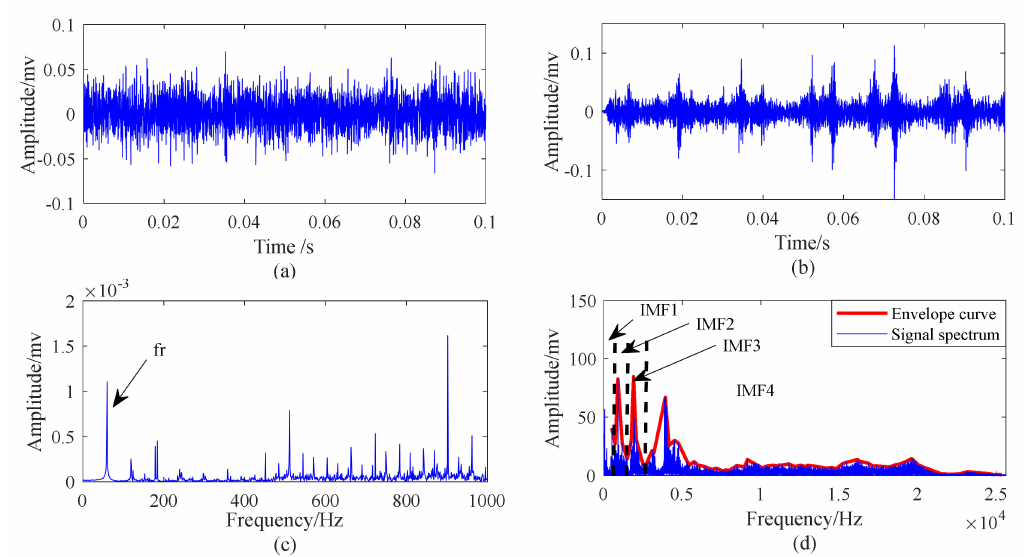
Figure 36. The collected signal of the bearing with 3 mm inner race fault and the result of the collected signal processed by the MCKD-EWT method: ( a ) the original signal; ( b ) the de-noised signal processed by MCKD method; ( c ) the spectrum of the original signal; ( d ) the Fourier spectrum segmentation result of the de-noised signal obtained by Improved EWT method.